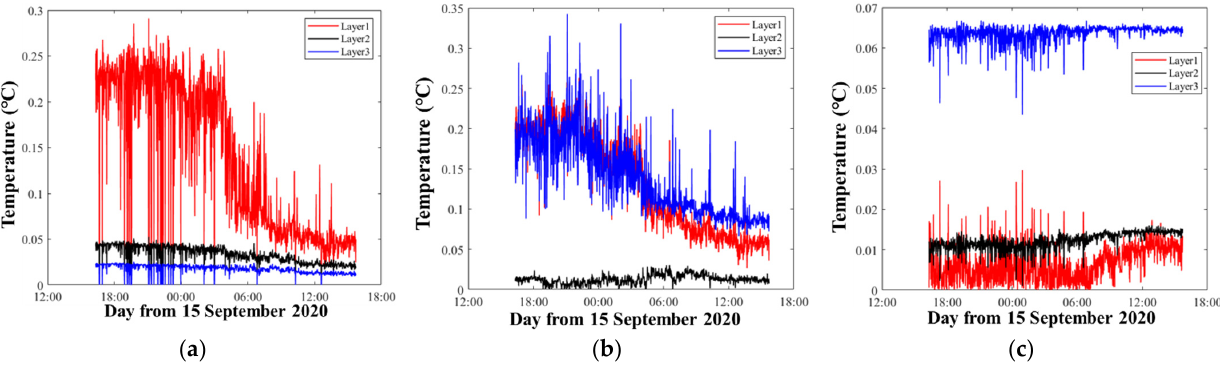
Figure 8. Temperature inversion errors. The red, black, and blue curves indicate the errors of the first layer, the second layer, and the third layer, respectively. ( a – c ) correspond to the results of Figure 6a–c,